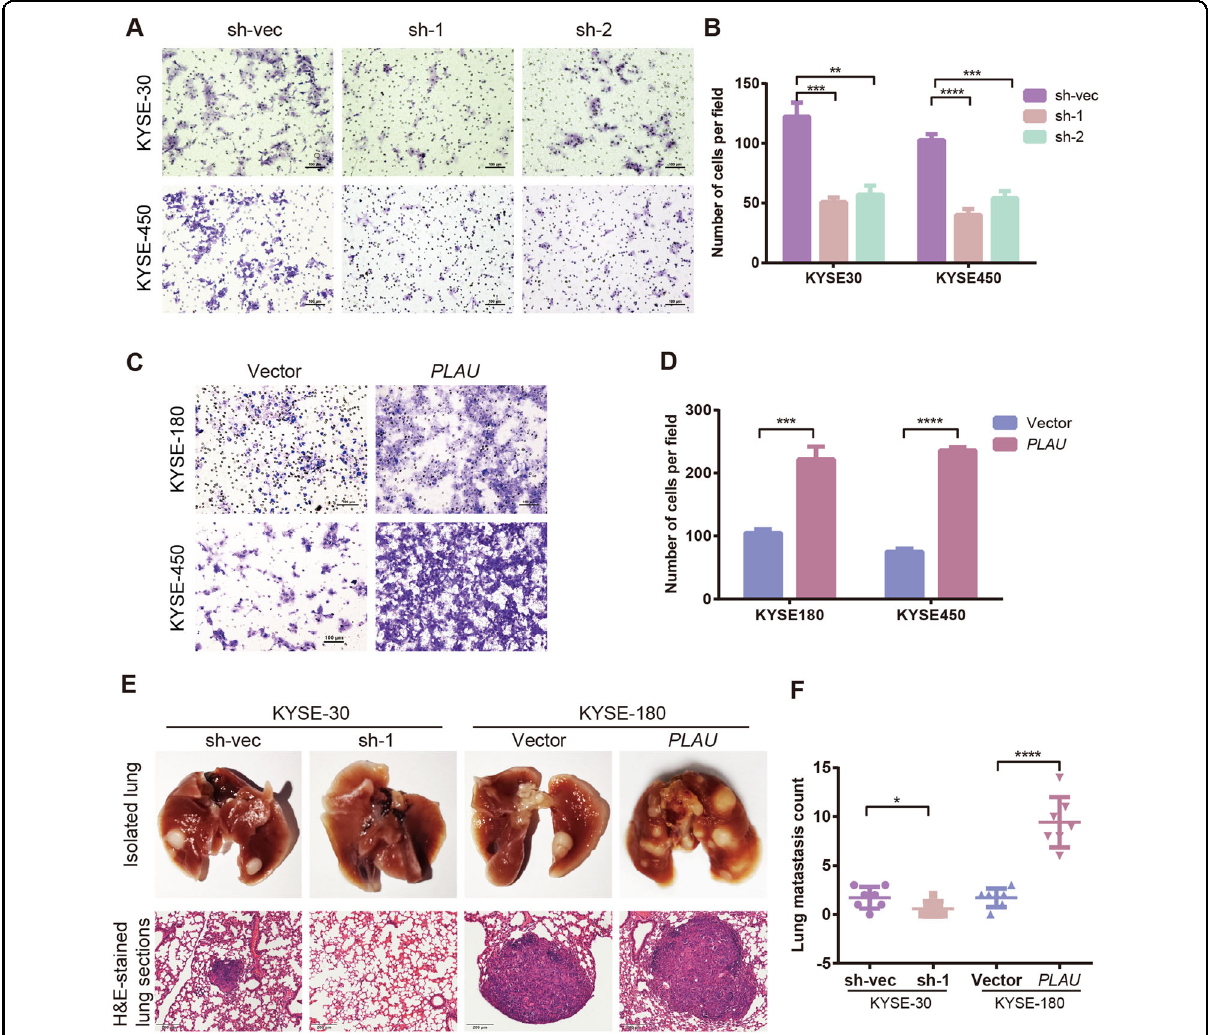
Fig. 3 PLAU promoted ESCC cell migration in vitro and in vivo. A – D The migrating ability of sh PLAU -1, sh PLAU -2, sh-vec KYSE-30 and KYSE-450 cells ( A ) and PLAU overexpressing KYSE-180 and KYSE-450 cells ( C ) was detected using transwell chamber assays. The numbers of migrating cells were compared between the groups ( B , D ). E , F Representative images of lung tissues isolated from mice injected with 1 × 10 6 sh PLAU -1 or sh-vec KYSE-30 cells, and PLAU overexpressing or vector KYSE-180 cells via the tail vein. Hematoxylin (the top panel) and eosin-stained images (200×, scale bars, 200 µm) of such tissues, and quanti fi cation of lung metastasis (female 4-week-old to 6-week-old NOID/SCID mice, n = 7 per group). Three biological replicates were performed for in vitro assays. Data in bar charts are presented as the mean ± SD. * P < 0.05, ** P < 0.01, *** P < 0.001, **** P < 0.0001 (Student ’ s t